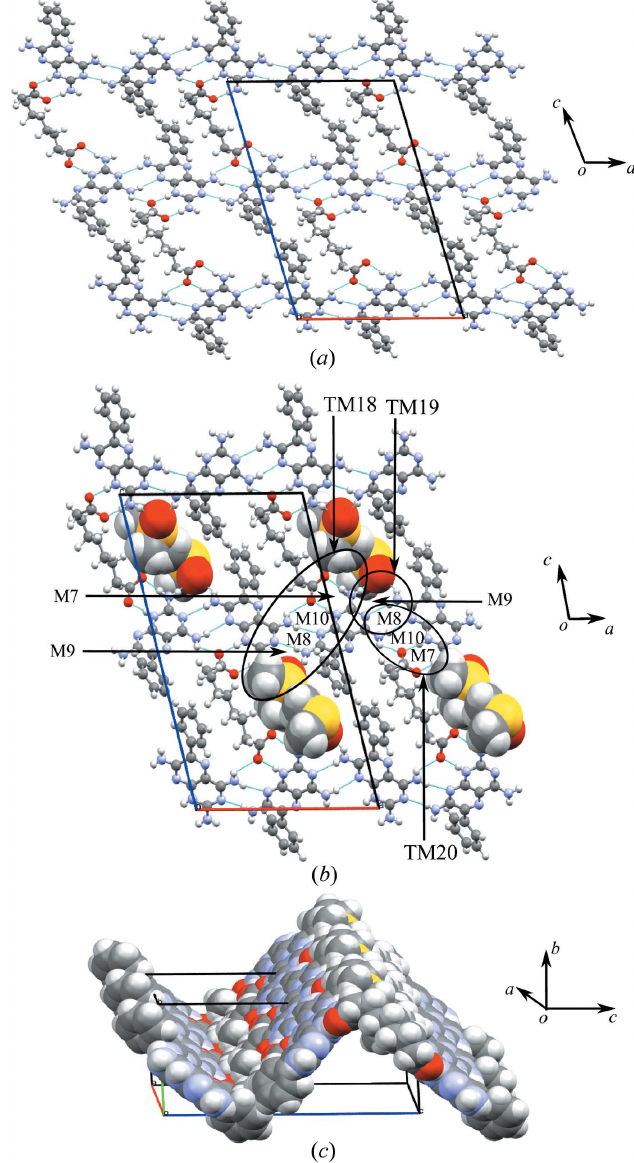
Figure 10 ( a ) The cyclic hydrogen-bonded host network. ( b ) The same network with each cavity filled with two DMSO molecules showing the motifs M7, M10, M8 and M9 (TM18), M8 and M9 (TM19), and M7, M10 and M8 (TM20). ( c ) The space-filling model showing the zigzag nature of the 1e (cid:3) DMSO sheets.